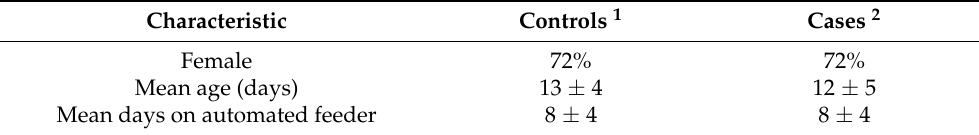
Table 1. Baseline characteristics of case and control calves where control calves ( n = 31) did not have neonatal calf diarrhea (NCD), and case calves ( n = 31) did. Cases of NCD were defined as having a fecal consistency score of 2 or 3 (e.g., runny to watery consistency) for two or more days. Cases calves were matched to control calves based on farm, sex, and age. All calves incurred NCD preweaning and were fed by automated milk feeder. Controls 1 Cases 2 Female 72% 72% Mean age (days) 13 ± 4 12 ± 5 Mean days on automated feeder 8 ± 4 8 ± 4 1 Controls = calves without neonatal calf diarrhea (NCD); 2 Cases = sick calves with NCD.